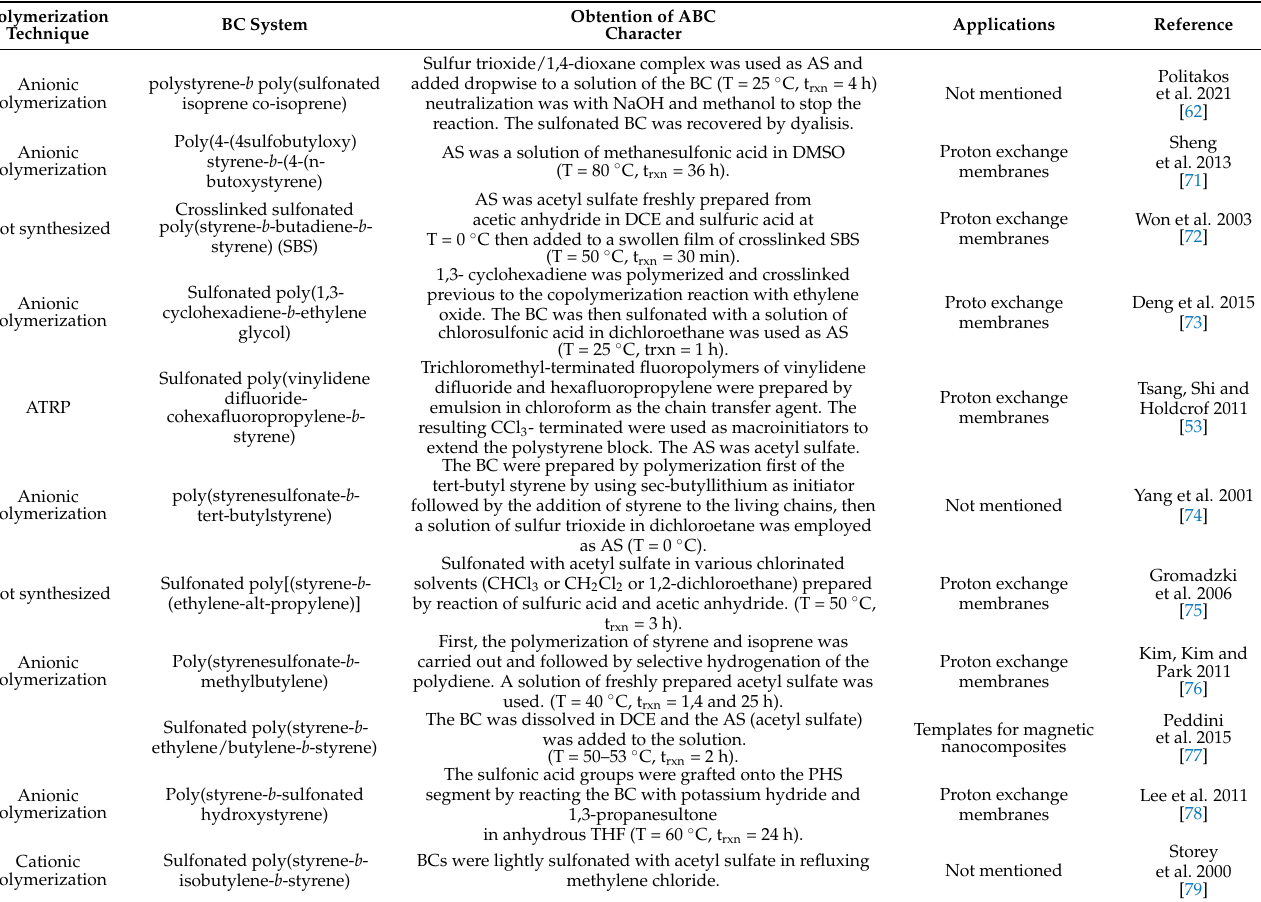
Table 2. Recent literature published employing post sulfonation reaction into the